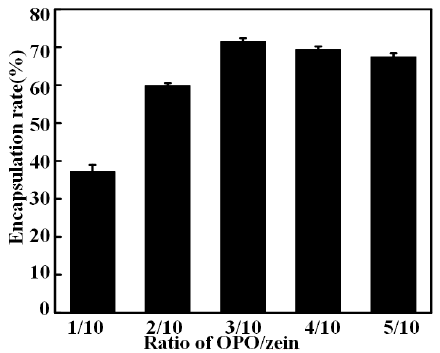
Figure 2. Encapsulation rate of different mass ratios of OPO/zein (1/10, 2/10, 3/10, 4/10, 5/10).